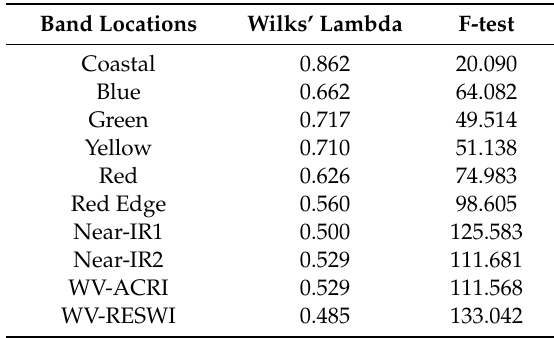
Table 4. A summary table of the Wilks’ Lambda test outputs and F-test significance values for discriminating the six tree species in the study.